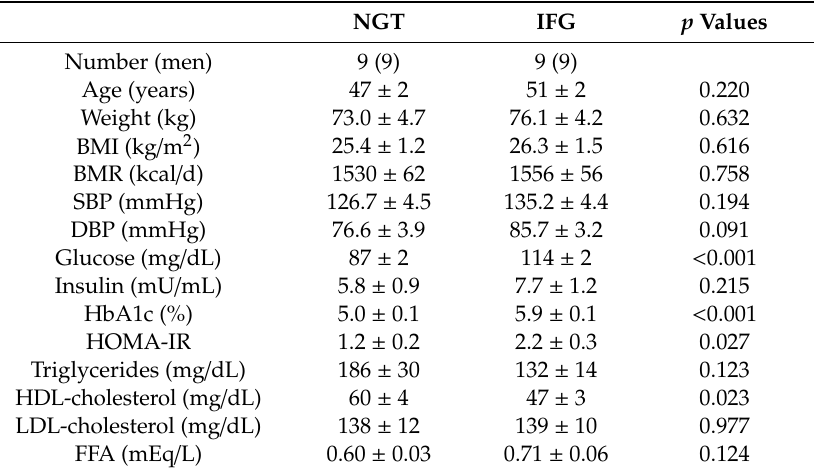
Table 1. Subject characteristics 1